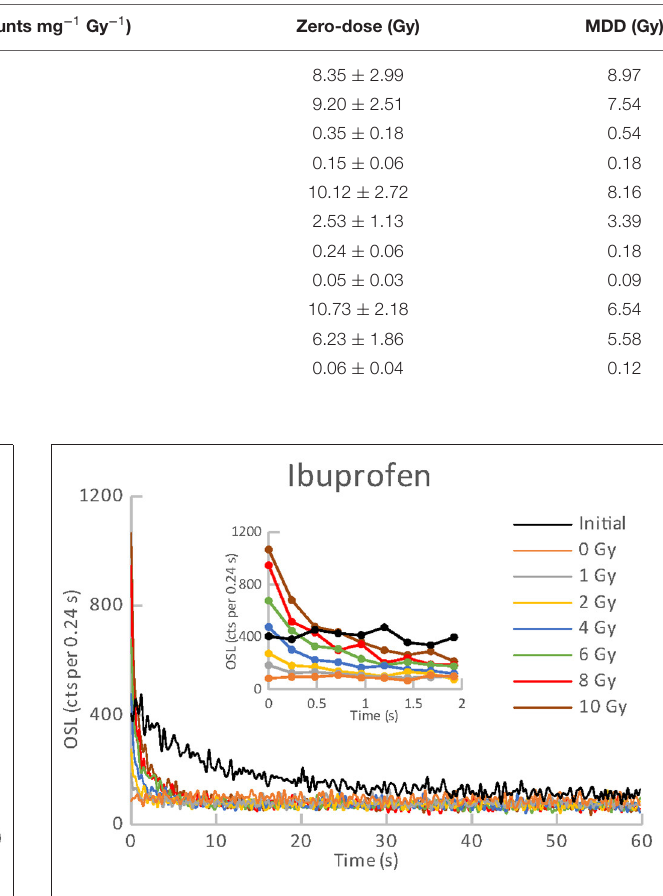
FIGURE 1 | OSL curves for the initial readout and subsequent post-irradiations readouts of an aliquot of Acylpyrin.